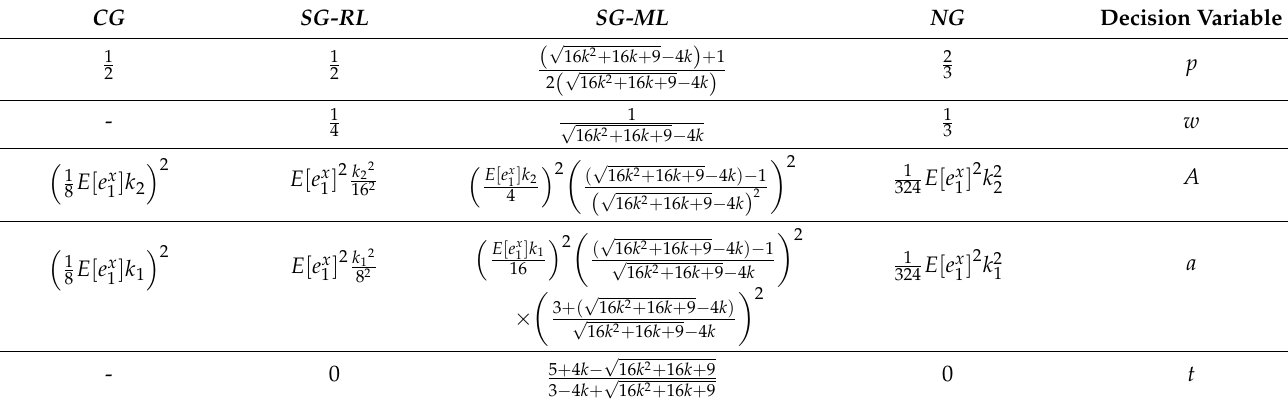
Table 2. Optimal values for the decision variables under the four strategies for the second